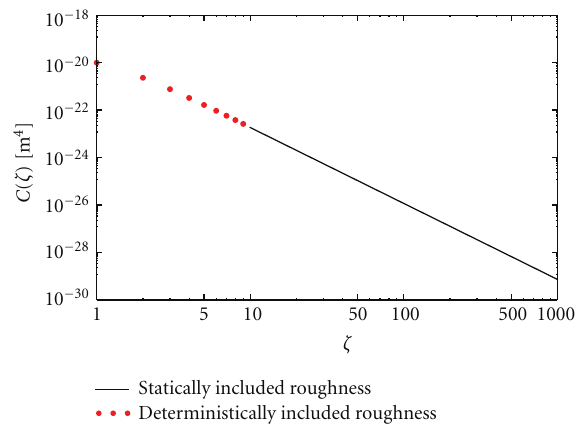
Figure 2: A self-a ffi ne power spectral density of a generic surface roughness. Points correspond to that spectral content included deterministically in the calculations, whereas the continuous line represents the homogenized surface